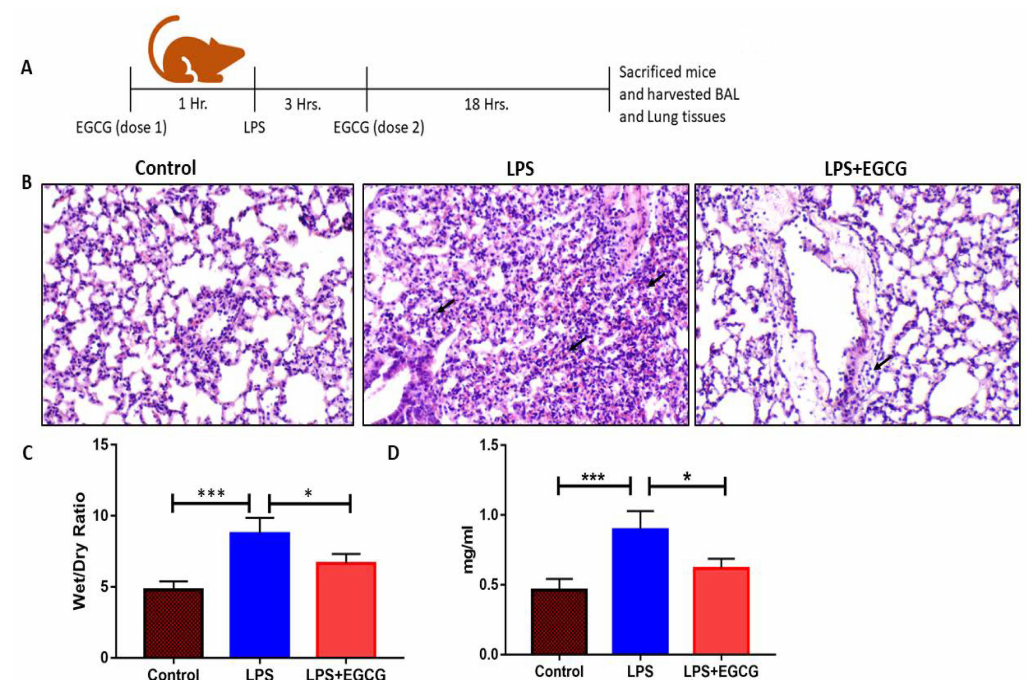
Figure 1. EGCG reduced histopathological damage and oedema in lipopolysaccharide (LPS)(IT)-induced lung. ( A ) Schematic to perform mice experiments for the study. ( B ) Representative histological slides of the lungs of designated groups (H&E staining, 10 × ). Enhanced inflammatory cells infiltration in the alveolar area of the lung in the LPS-instilled group when compared with the control group. Administration of EGCG suppressed infiltration of cells and less dense histoarchitecture of lung tissue. ( C ) Wet / dry ratio was significantly enhanced after LPS instillation, administration of EGCG significantly inhibits LPS-induced lung wet / dry ratio. ( D ) Total protein of bronchoalveolar lavage (BAL) fluid was measured after 18 h of acute lung injury (ALI) induction in di ff erent treatment groups. Significant upregulation in BAL protein levels after LPS(IT) instillation, treatment of EGCG suppressed this increased protein levels. Significant di ff erence * p < 0.05 and *** p <